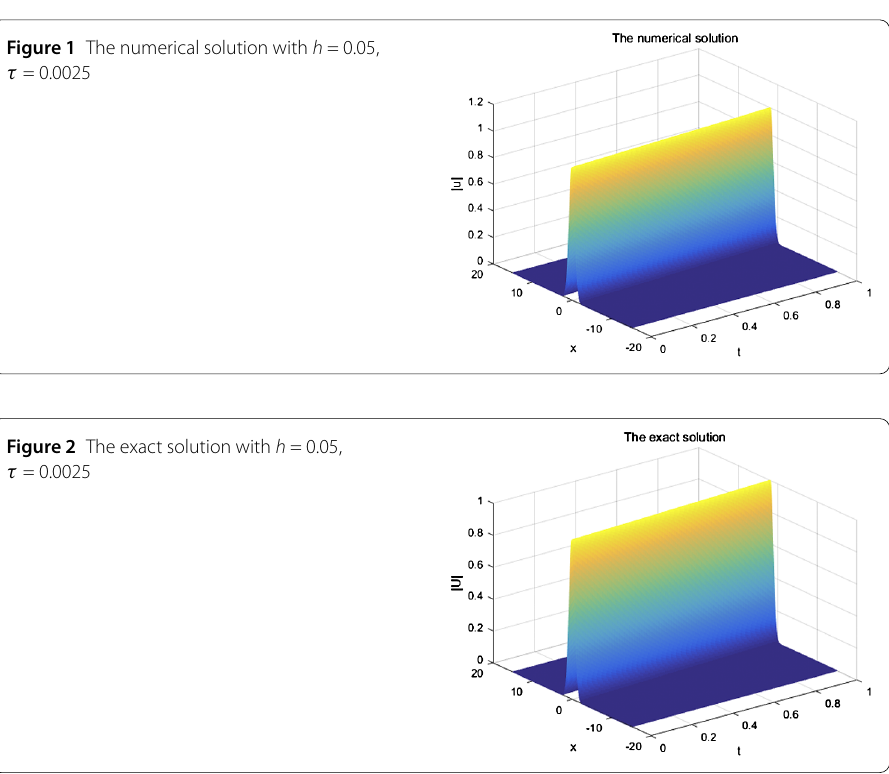
Table 1 Comparison of the accuracy for the numerical solutions t CFD Scheme Scheme 2 Scheme 3